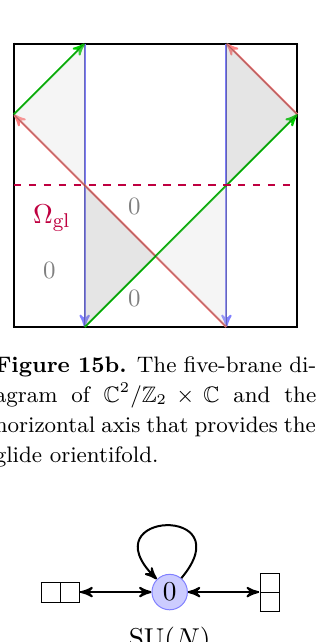
Figure 16. The linear quiver resulting from the glide orientifold of C 3 / Z 2